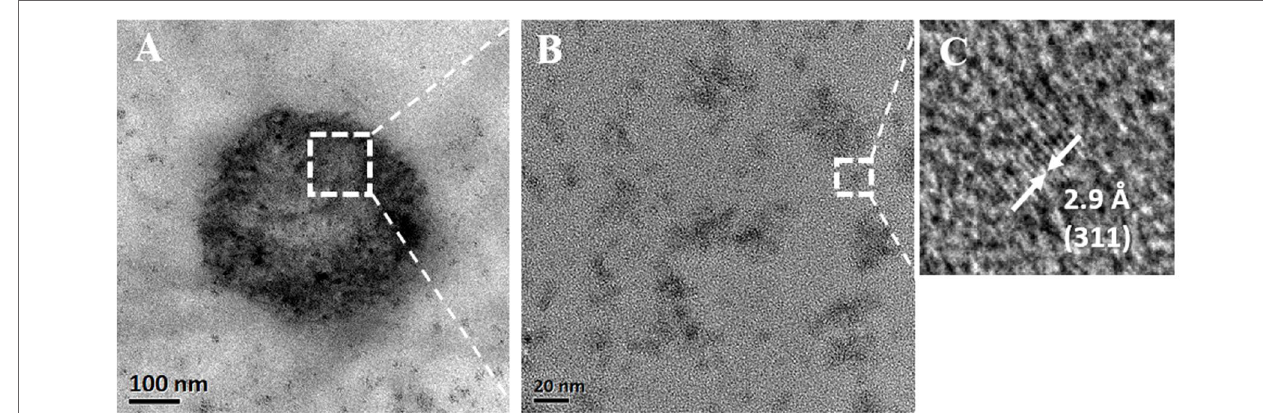
FIGURE 4 | (A) TEM image of an MOLNB; (B) HRTEM image of the square region in (A) ; (C) HRTEM image of the square region in (A) showing the (311) lattice planes of a